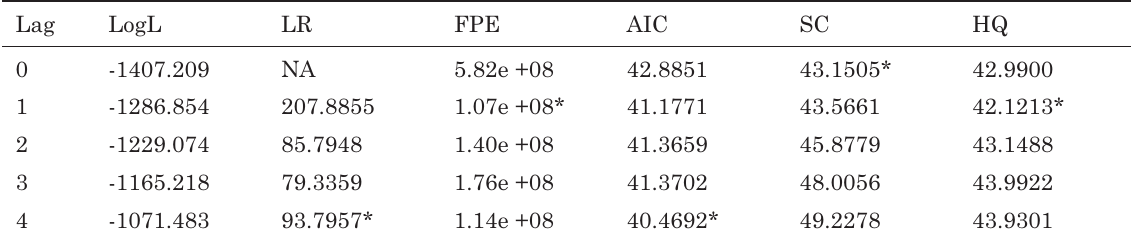
Table 2. Eight capital cities’ house price indexes VAR lag order selection criteria Lag